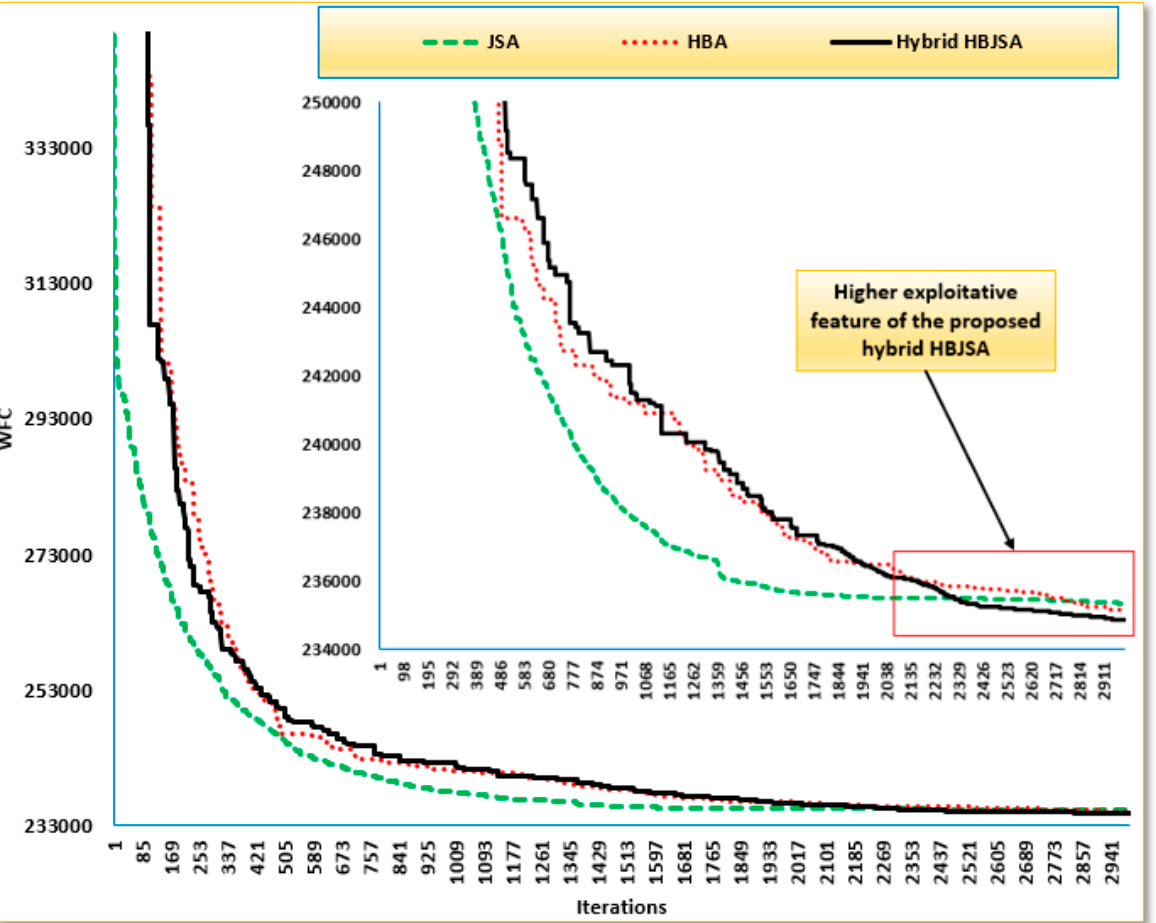
Figure 8. Convergence characteristics of the proposed HBJSA versus the HBA and JSA for the 96-unit system of CHP economic dispatch. Table 7. Comparison between HBA, JSA, and the proposed HBJSA for the 96-unit test system of CHP economic dispatch